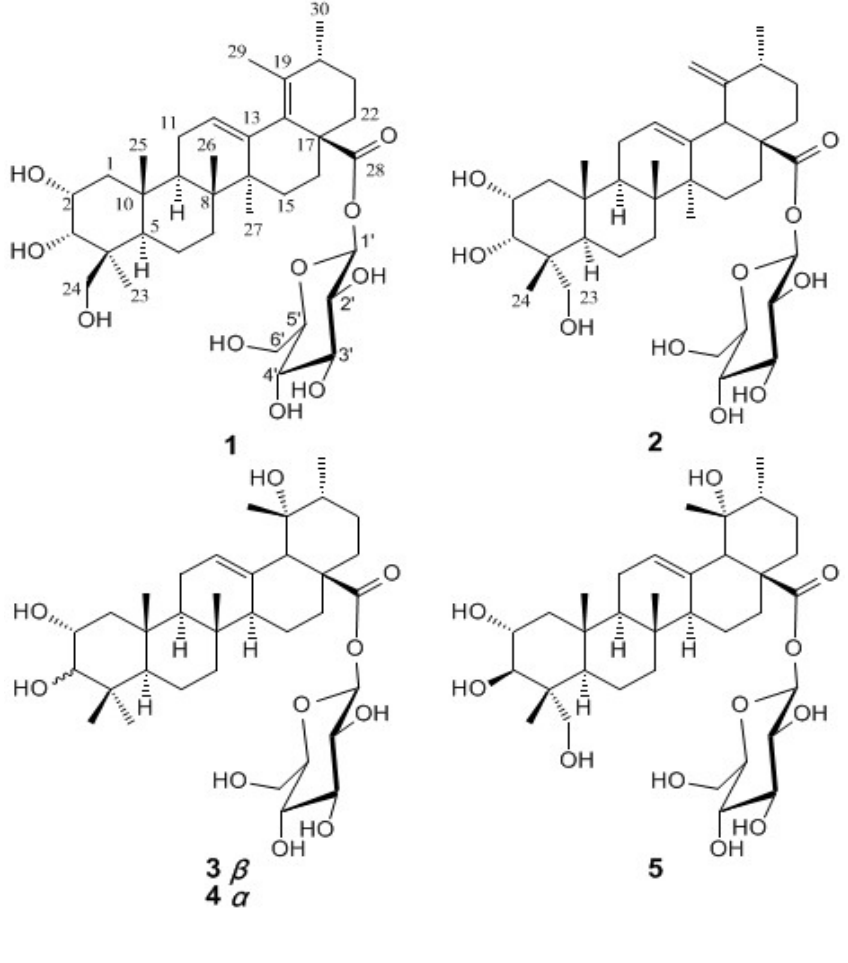
Figure 1. The structures of compounds 1 - 5